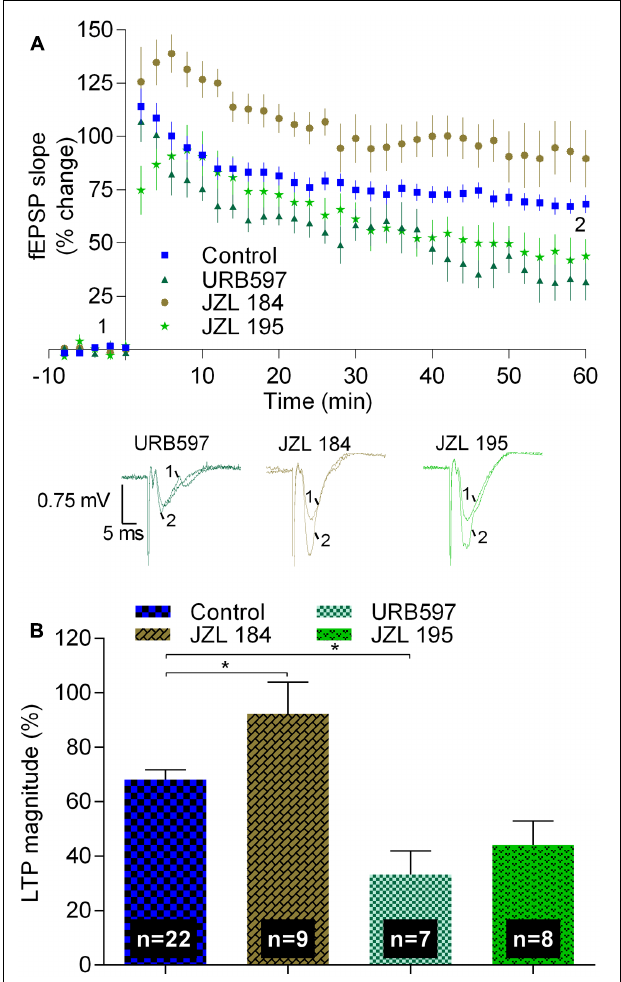
FIGURE 4 | LTP induced by strong- θ -burst is inhibited when CB 1 Rs are continuously activated. (A) Time course of the averaged fEPSP slopes, and original traces of fEPSP recordings, in control conditions (no drugs) or in the presence of 500 nM WIN (CB 1 R agonist), or 500 nM WIN together with 1 µ M AM251. (B) Quantification of LTP magnitude under the indicated drug conditions. Data in control conditions in panels (A) and (B) are the same as shown in Figures 2A,B , but is represented in this figure to allow comparison with the drug conditions. ∗∗∗∗ p < 0.0001 ( F ( 2 , 33 ) = 10.3, one-way ANOVA with Sidak’s correction). For further details see legend to Figure 1